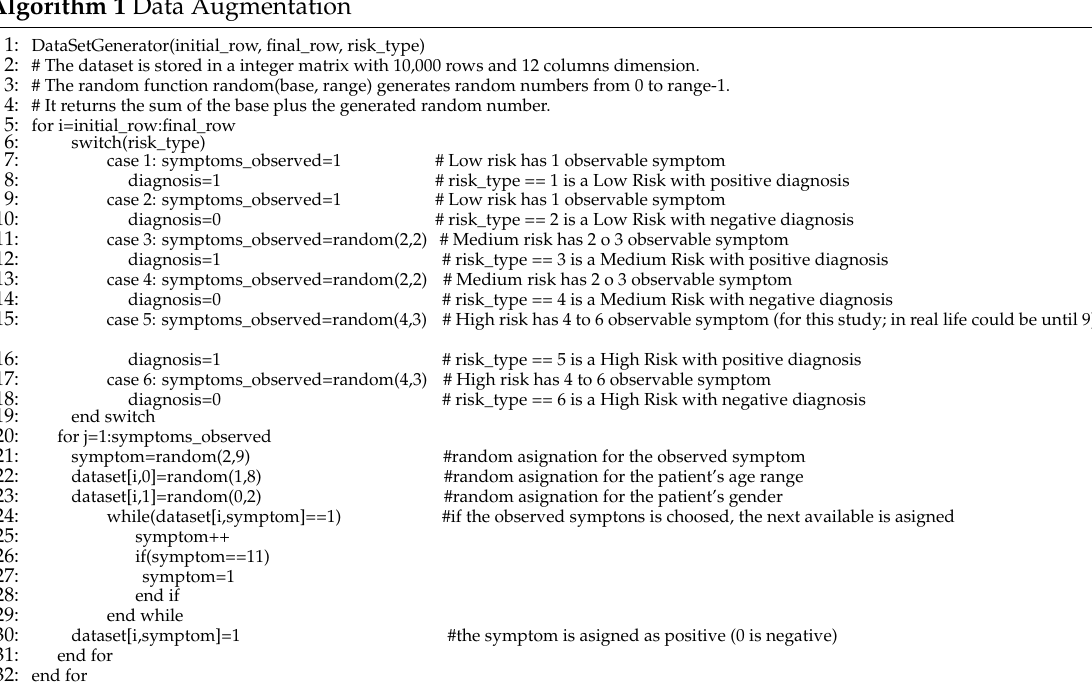
Algorithm 1 Data Augmentation